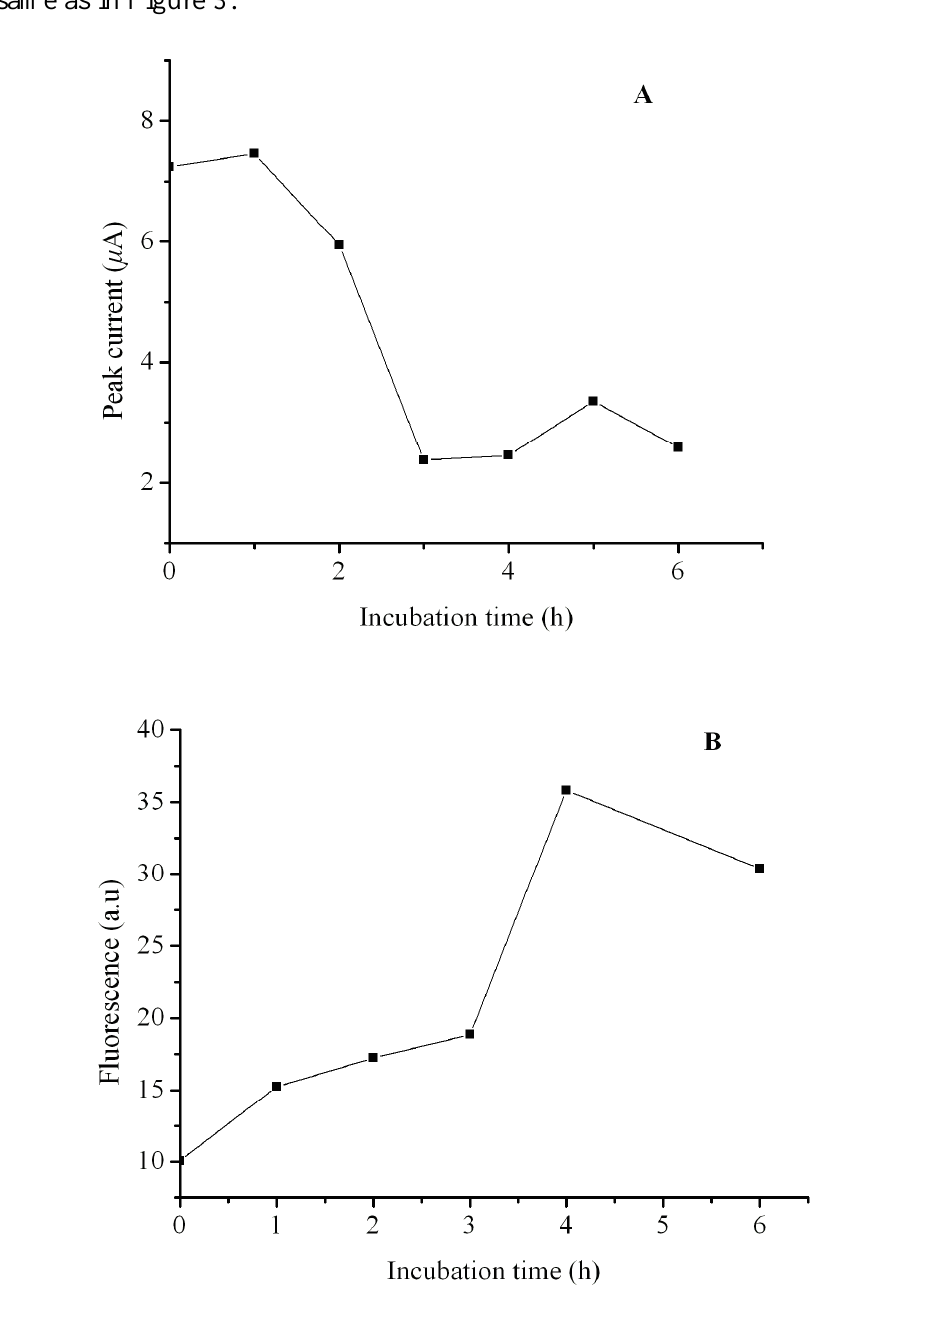
Figure 4. (A) Relationship between the oxidation peak current in the square wave voltammograms of hIAPP and the incubating period. (B) Relationship between the fluorescent intensity of thioflavin-T treated hIAPP solution and the incubating period. Others same as in Figure